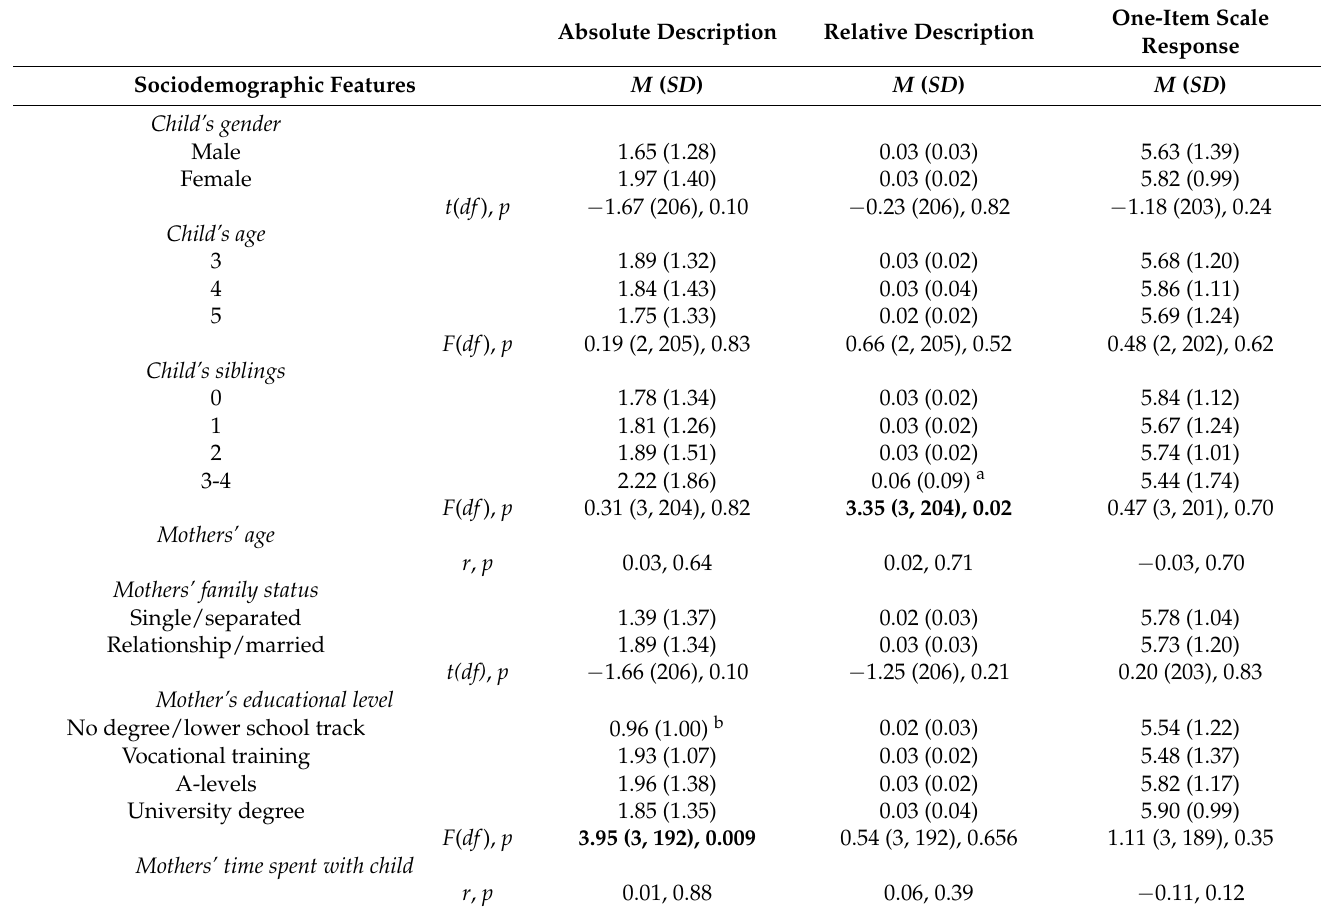
Table 3. Distributions and statistics of mothers’ perceptions of their children’s playfulness across socioemotional features of the children and mothers. Mothers’ Playfulness Perceptions of Their Children Absolute Description Relative Description